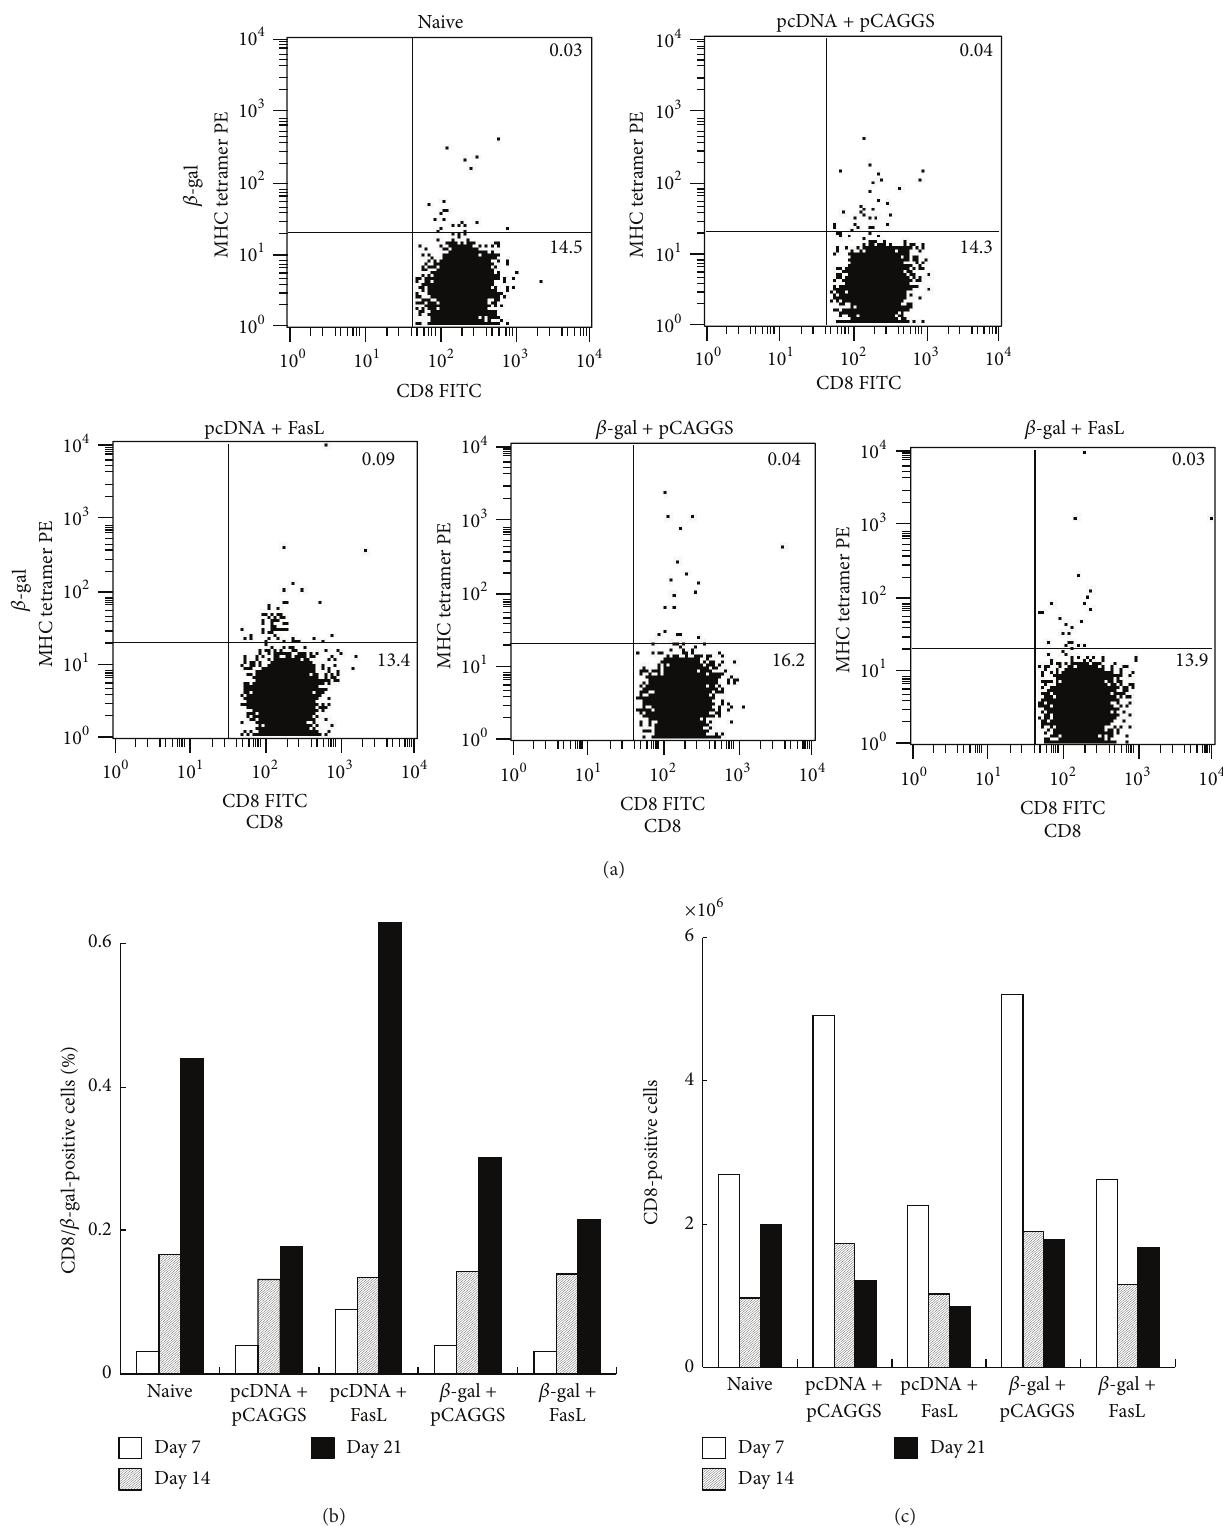
Figure 3: Representative data on frequency of 𝛽 -gal-specific CD8 + T cells in inguinal lymph nodes. BALB/c mice were pretreated with cardiotoxin and then uninjected (naive) or injected with pcDNA3 + pCAGGS, pcDNA3 + pCAGGS/FasL, pcDNA3/ 𝛽 -gal + pCAGGS, or pcDNA3/ 𝛽 -gal + pCAGGS/FasL (50 𝜇 g DNA for each). (a) Representative cell surface staining profiles of the lymph nodes 7 days after DNA immunization. The number indicates a percentage of each fraction. (b) Percentages of CD8 + / 𝛽 -gal-positive T cells in respective mice on days 7, 14, and 21 after DNA immunization. (c) Percentages of CD8 + T cells in respective mice on days 7, 14, and 21 after DNA